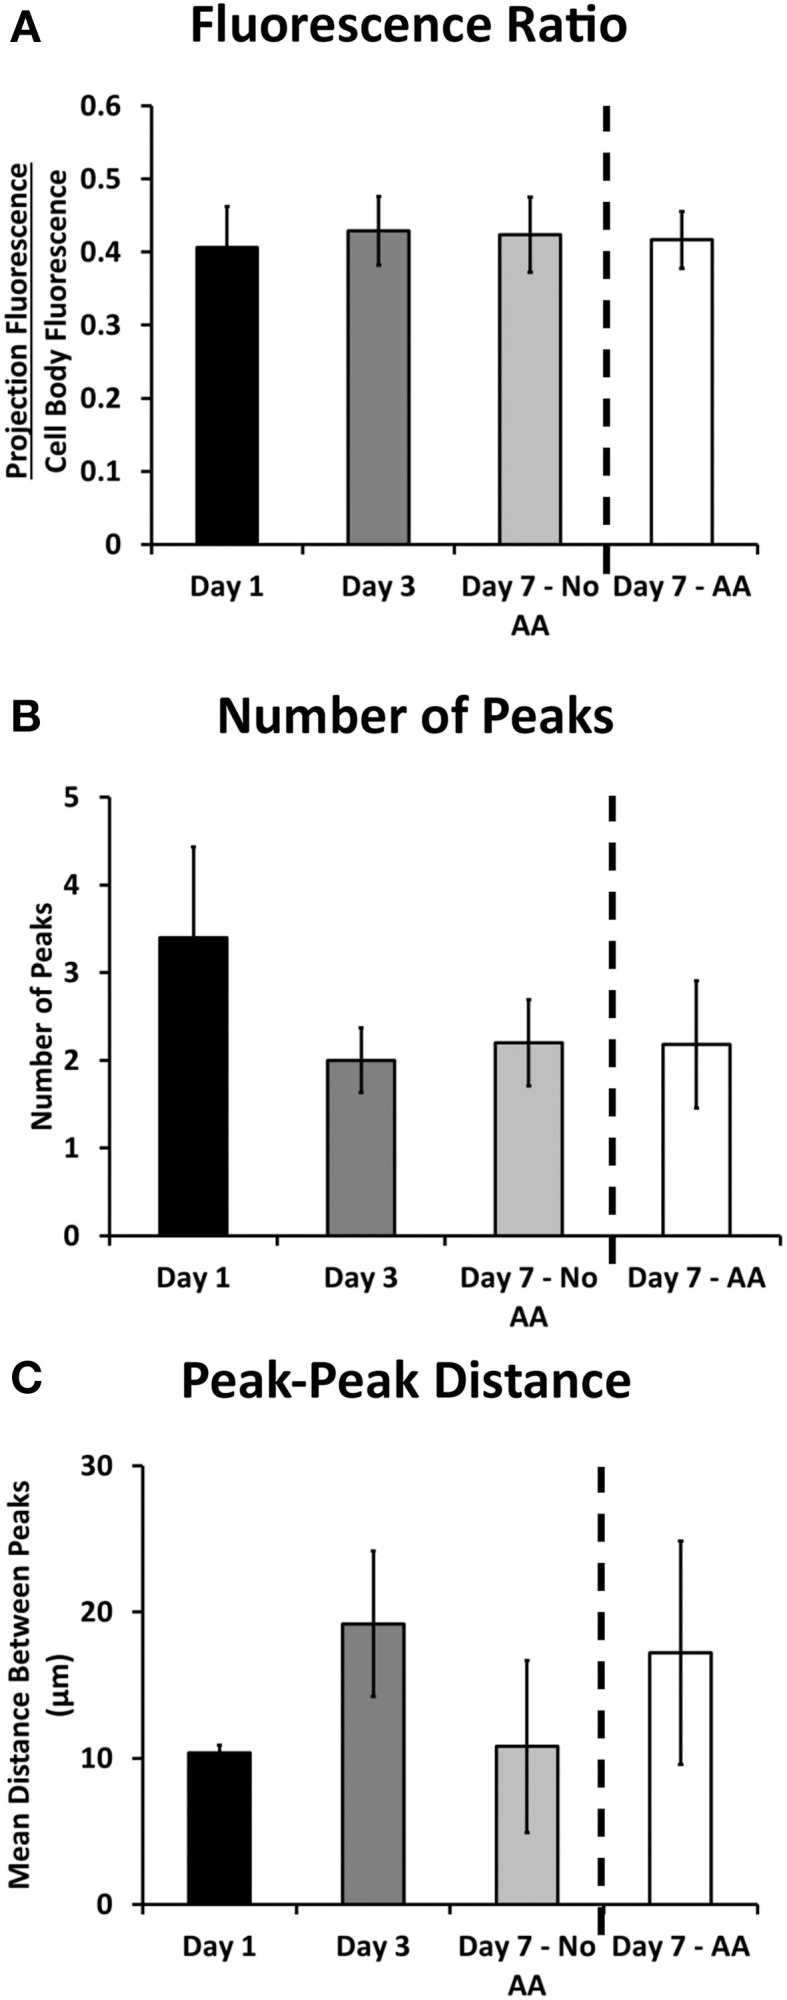
Ribosomal expression in the projections of Schwann cells remained relatively consistent throughout the experimental proceedings according to a number of metrics. (A) The ratio of fluorescence in the projection compared to the cell body remained consistent throughout the experimental groups; (B) The number of observed ribosomal peaks (or puncta) did not vary significantly throughout the experimental groups; (C) The distance between peaks varied albeit not significantly throughout the experiment (Means ± SEM). Statistics: 1-way ANOVA.